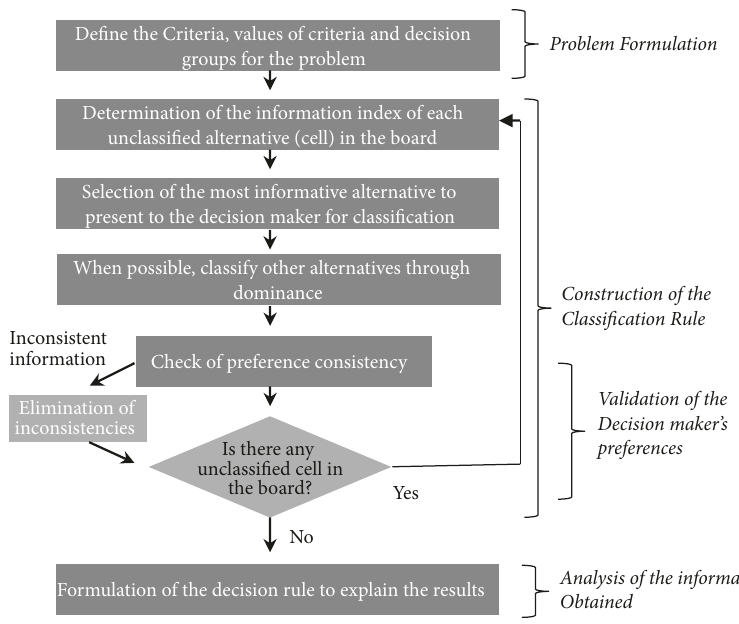
Figure 4: ORCLASS methodology